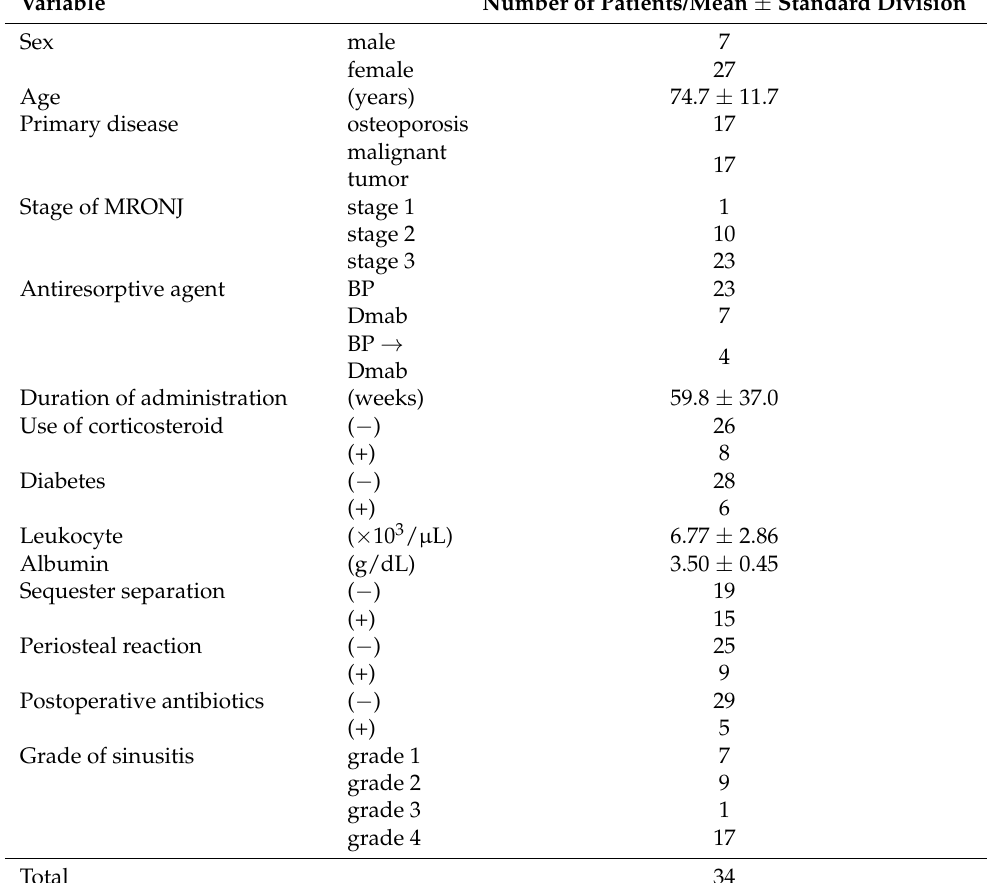
Table 1. Patient